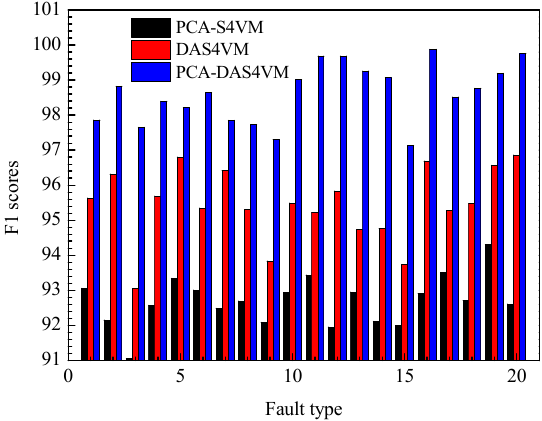
Figure 10. F1 scores for PCA-S4VM, DAS4VM, and PCA-DAS4VM models.